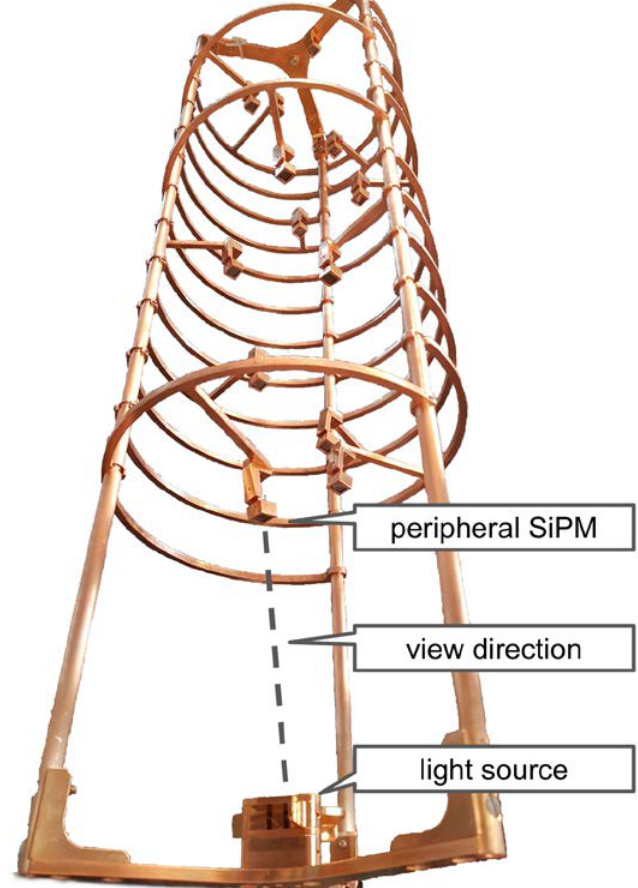
Fig. 6. Picture of the LLAMA setup. The copper structure is about 85 cm high and holds 13 SiPMs in the top part of the setup as well as the triangular shaped light source, mounted on the bottom plate.